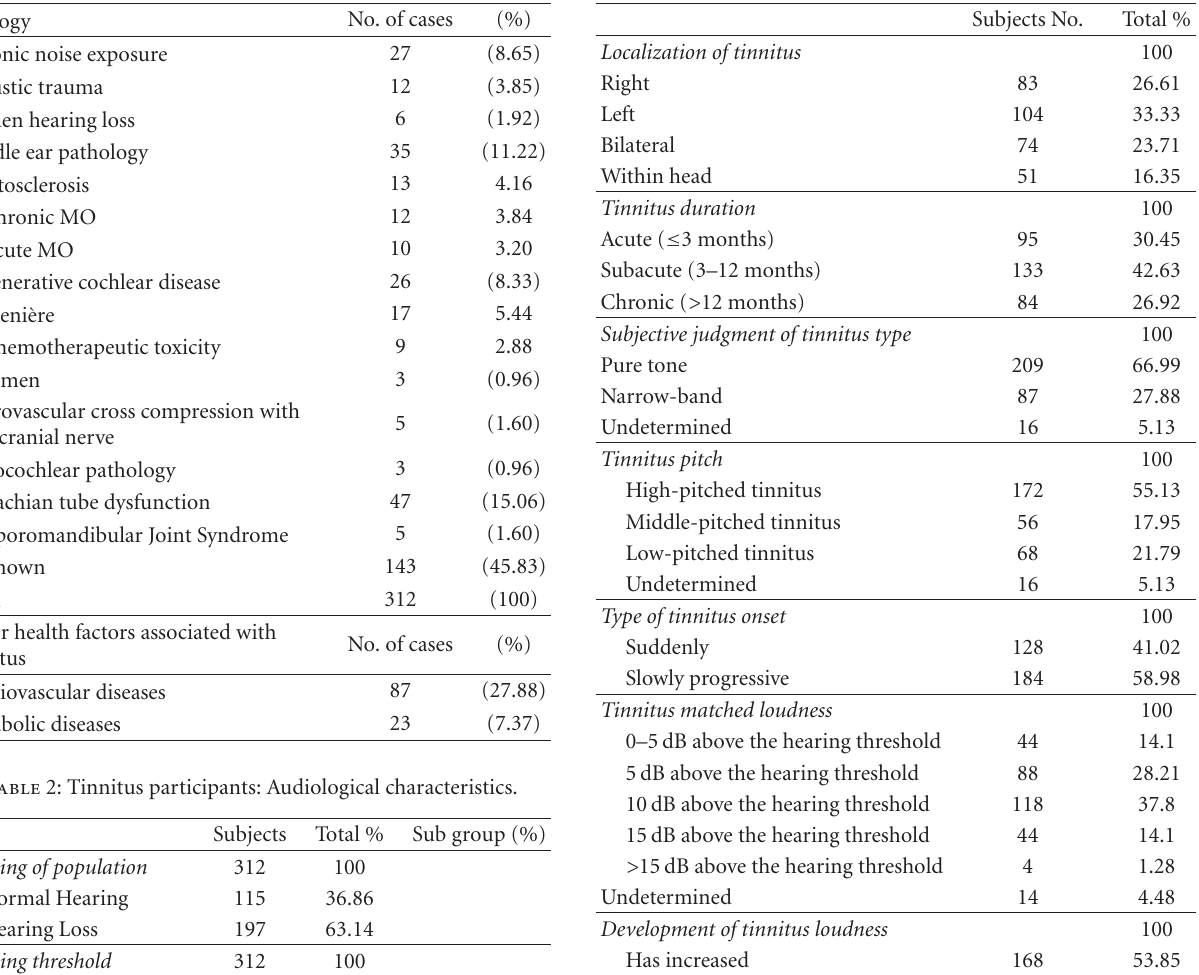
Table 1: Tinnitus etiologies and health factors associated.